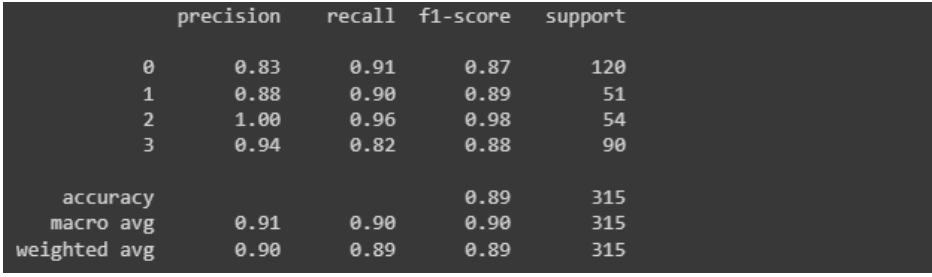
Figure 16. Classification report for the third model.